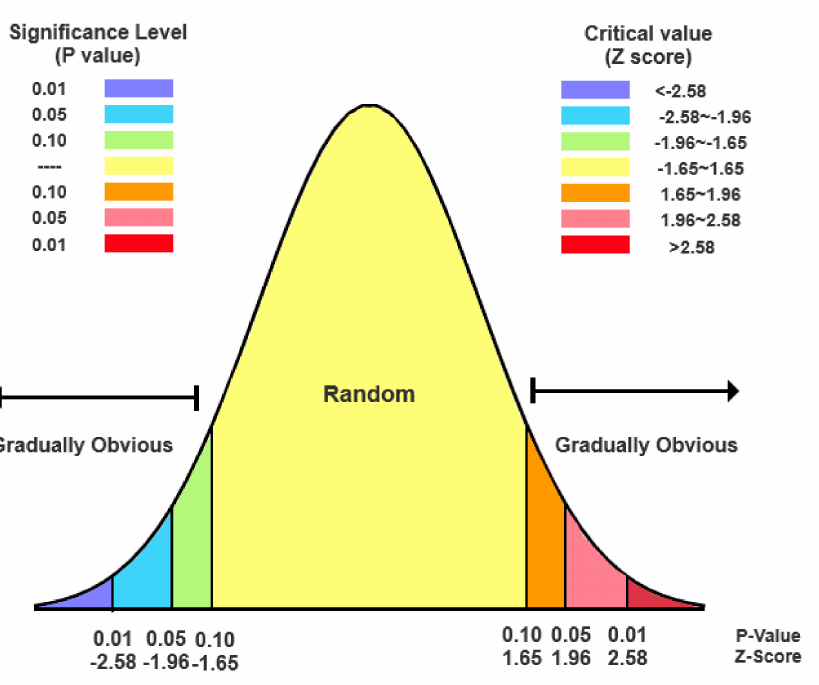
Figure 4. Normal distribution of p -value and Z-score.